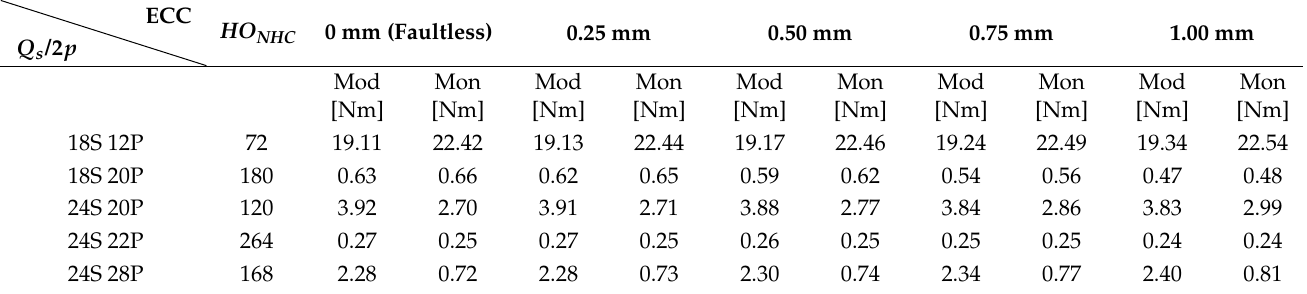
Table 9. Cogging torque NHC of different PMSM and MPMSM-slot/pole combinations in the presence of